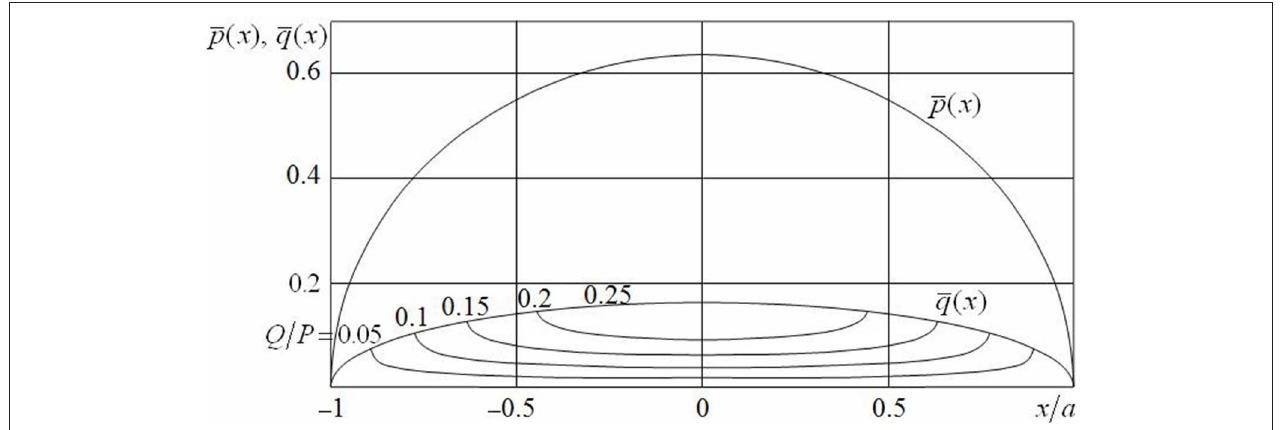
FIGURE 2 | Distribution of normal